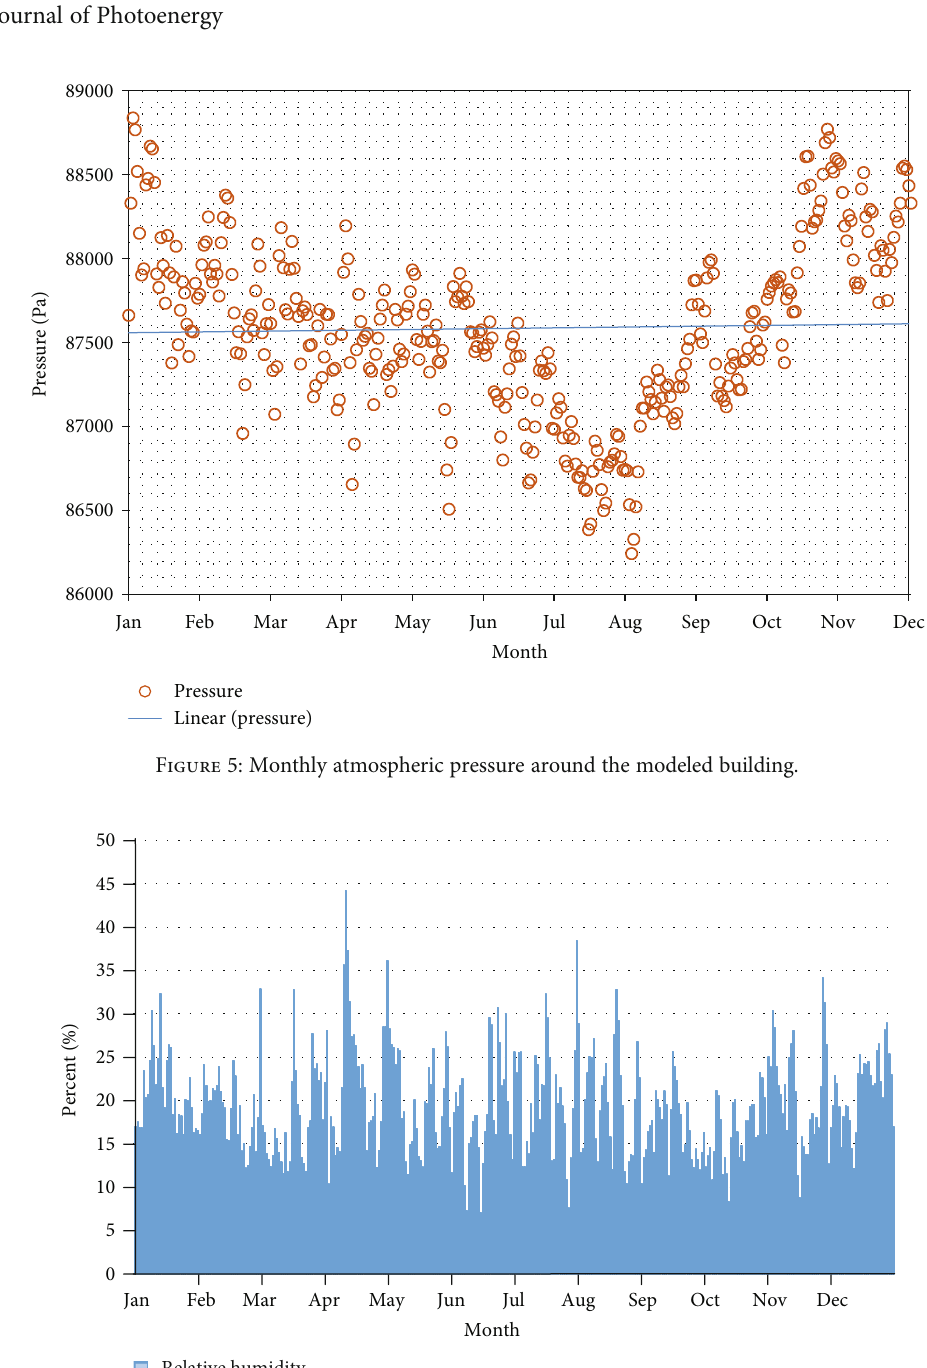
Figure 6: Annual relative humidity around the modeled building.